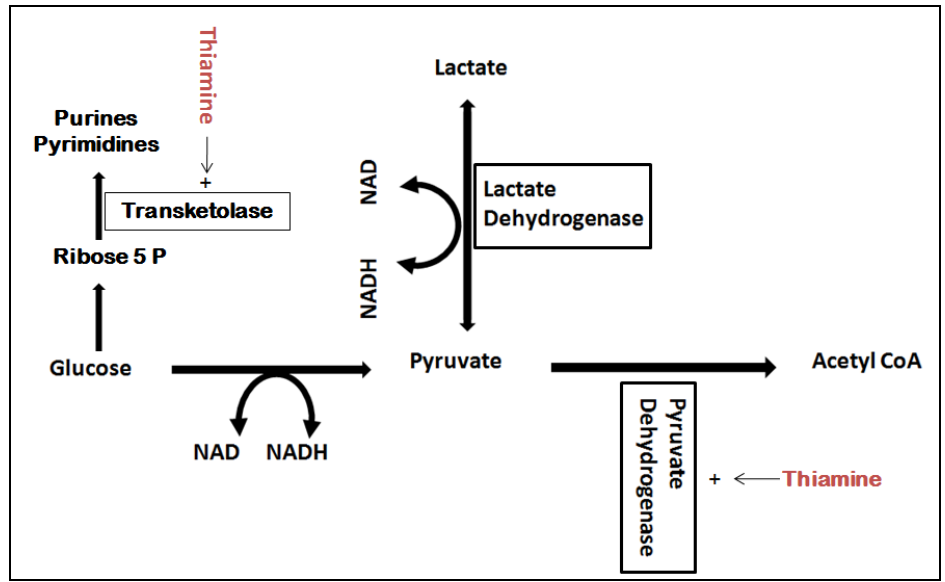
FIGURE 2. Lactic acid synthesis and role of thiamine as a cofactor of pyruvate dehydrogenase and transketolase enzyme